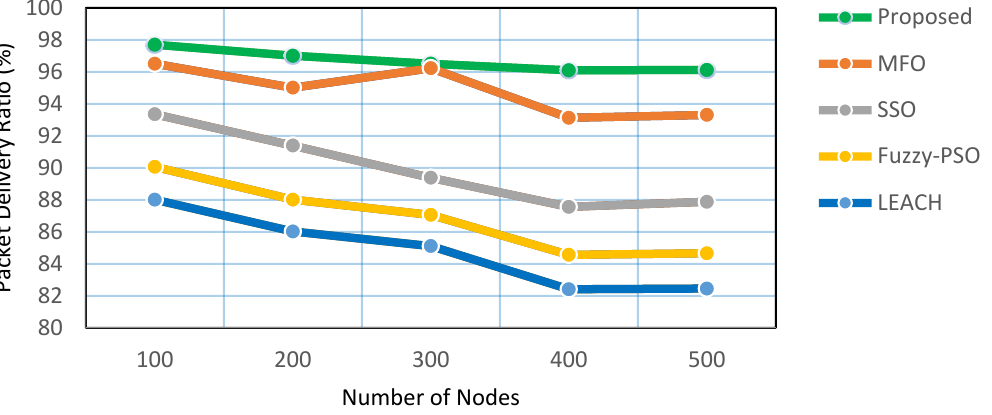
Figure 7. Analysis of packet delivery ratio vs. number of nodes. Table 7. Comparison of packet delivery ratio with various routing protocols.